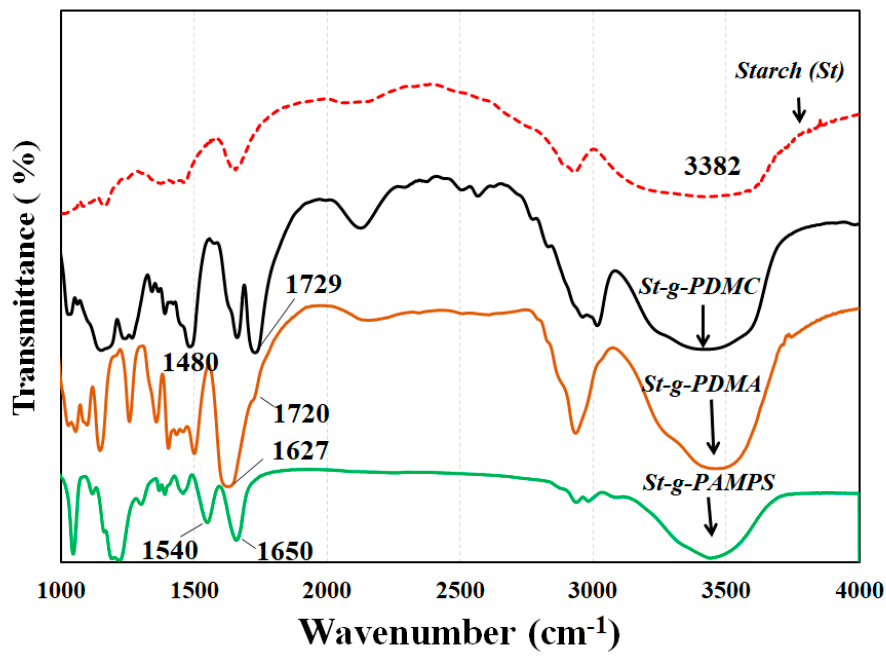
Figure 5. FTIR spectra of starch (St) and St ‐ g ‐ PDMC, St ‐ g ‐ PDMA, and St ‐ g ‐ PAMPS.